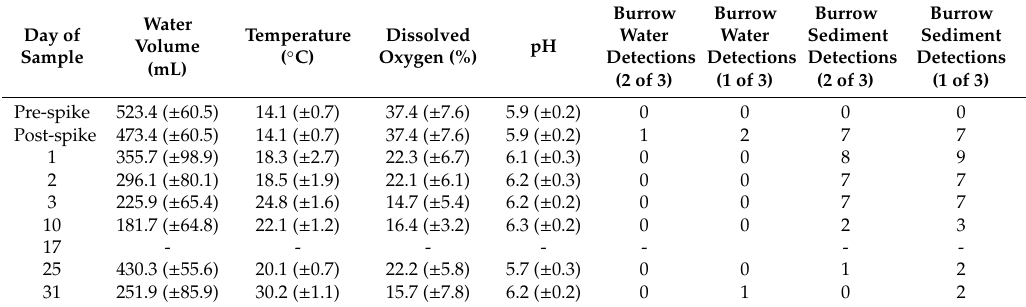
Table 3. Clonophis kirtlandii detections from artificial crayfish burrows (n = 10) in degradation study. Average ( ± standard deviation) values of water volume, temperature, dissolved oxygen, and pH are given for each sample day. The number of detections for burrow water and burrow sediment are given for each of two thresholds for assigning a positive (two of three and one of three qPCR replicates). Samples were unable to be collected at 17 days.